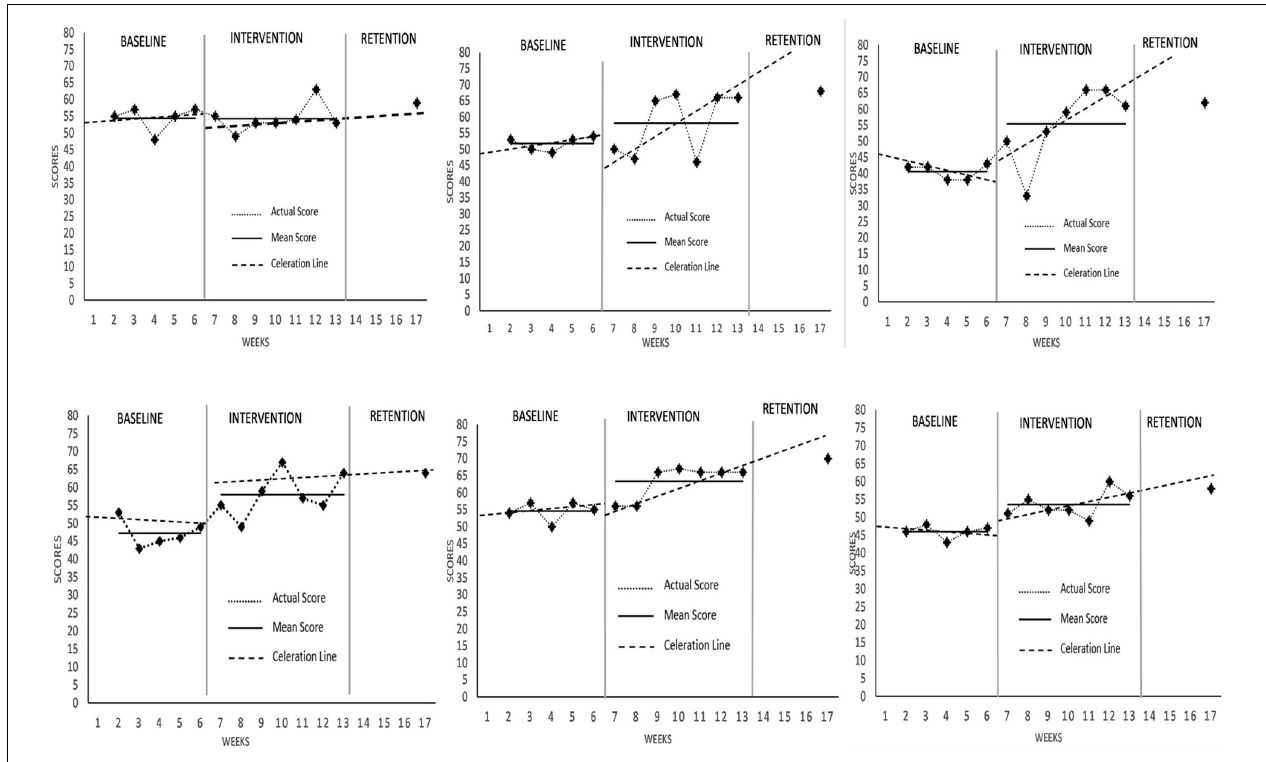
FIGURE 5 | Coach-rated performance scores across all